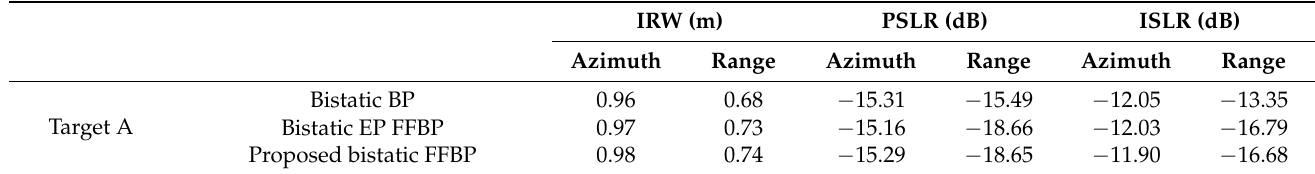
Table 3. Measured IRW, PSLR and ISLR of the selected